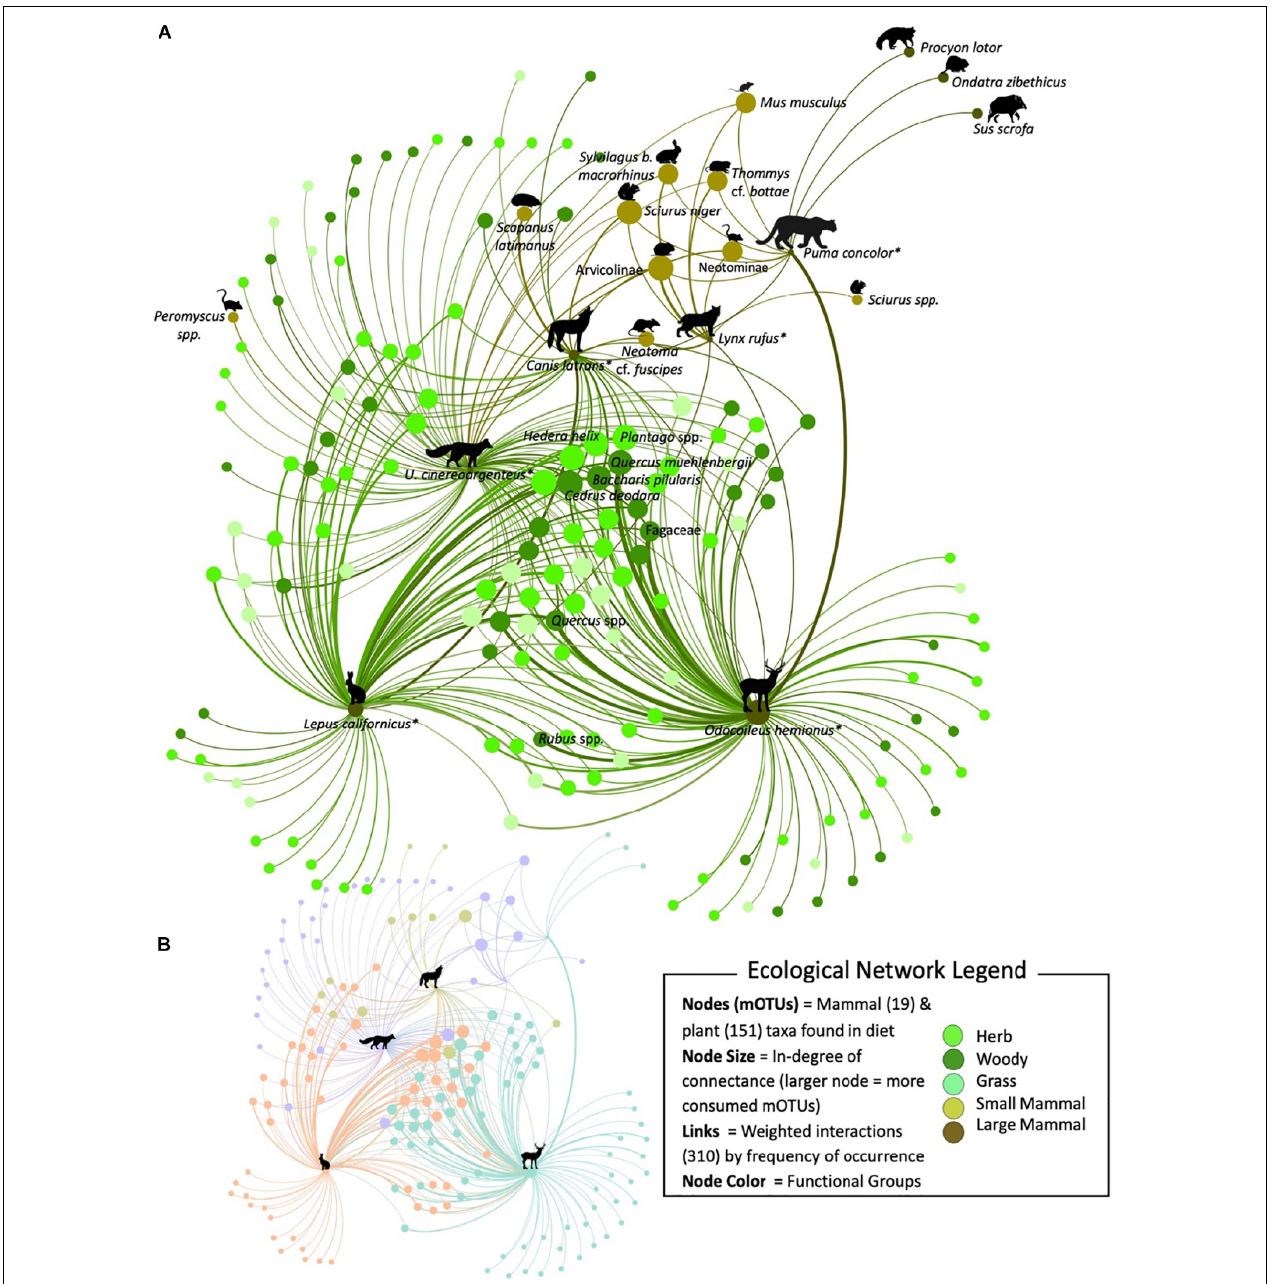
FIGURE 3 | A subset of the molecularly constructed food web of JRBP targeting the diets of black-tailed jackrabbit, black-tailed deer, gray fox, coyote, bobcat, and puma (*) represented by 170 nodes and 310 interactions. (A) Nodes are representing the predator – prey mOTUs and are color coded according to their functional group. The size of the node is proportional to the number of links connected (in-degree), and the width of the link is proportional to the frequency of occurrence the prey item was found in the diet across scat samples. The curve of the edge is always in a clockwise direction representing a weighted link from the consumer to the food item. All of the mammal mOTUs have been labeled, along with the most consumed plant mOTUs. (B) The colors in the scaled network represent the four different modular communities detected within the JRBP community and the icon represents the key species within each module.